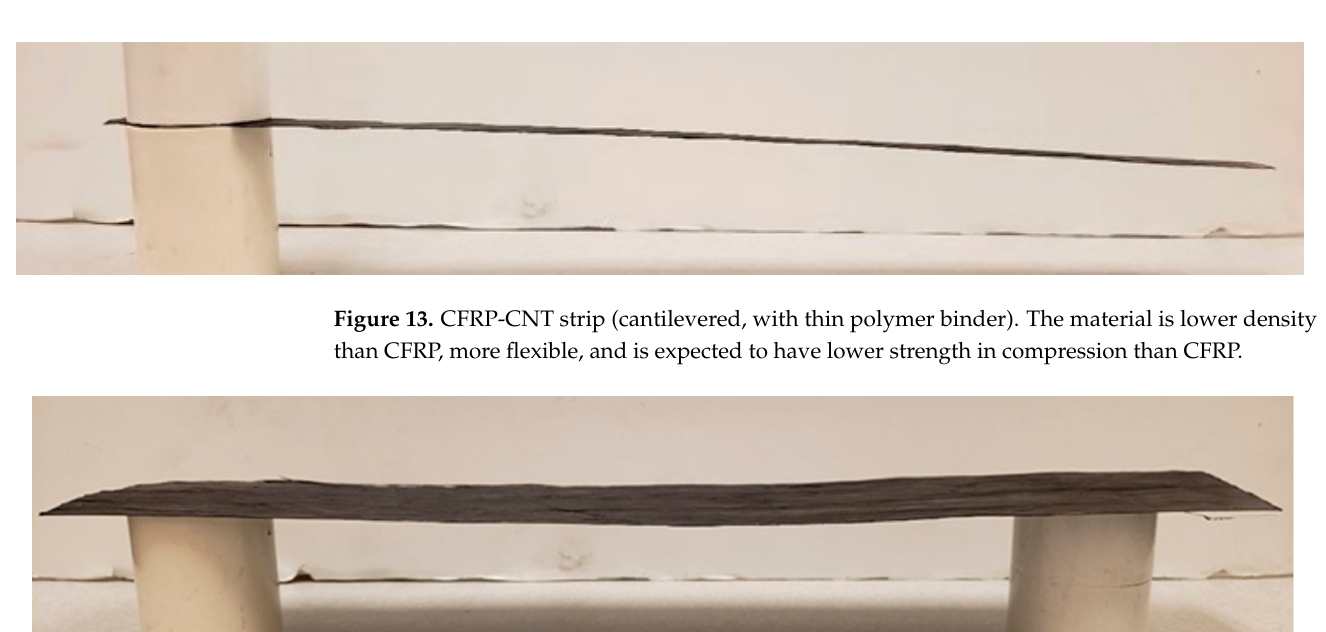
Figure 12. CF-CNT cylinders ( A , B ) rings. The material is flexible (not as brittle as CFRP) and is expected to have good tensile strength and toughness.